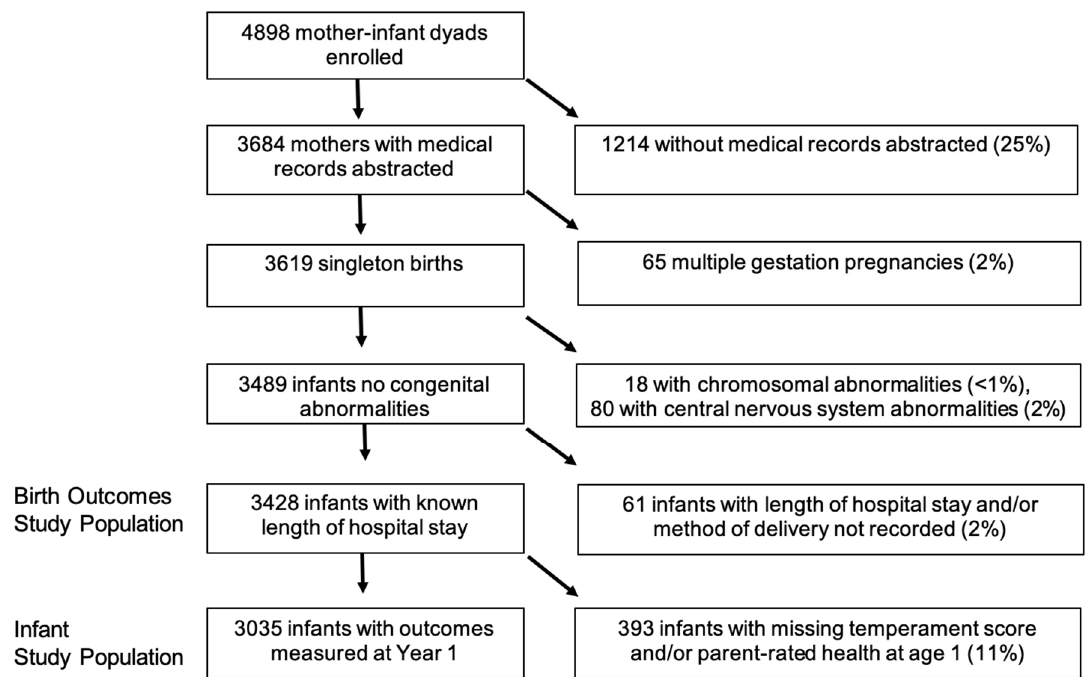
Figure 2. Flow diagram showing specification of study populations sourced from the Fragile Families and Child Wellbeing Study, 1998–2000.